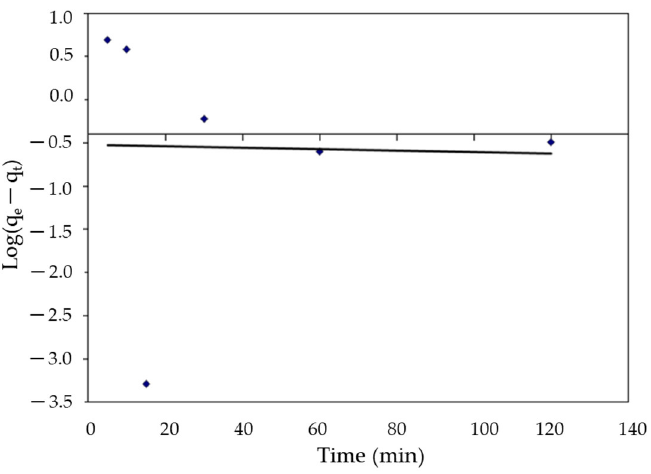
Figure 17. The pseudo-first-order equation for the elimination of MBD onto S. latifolium .